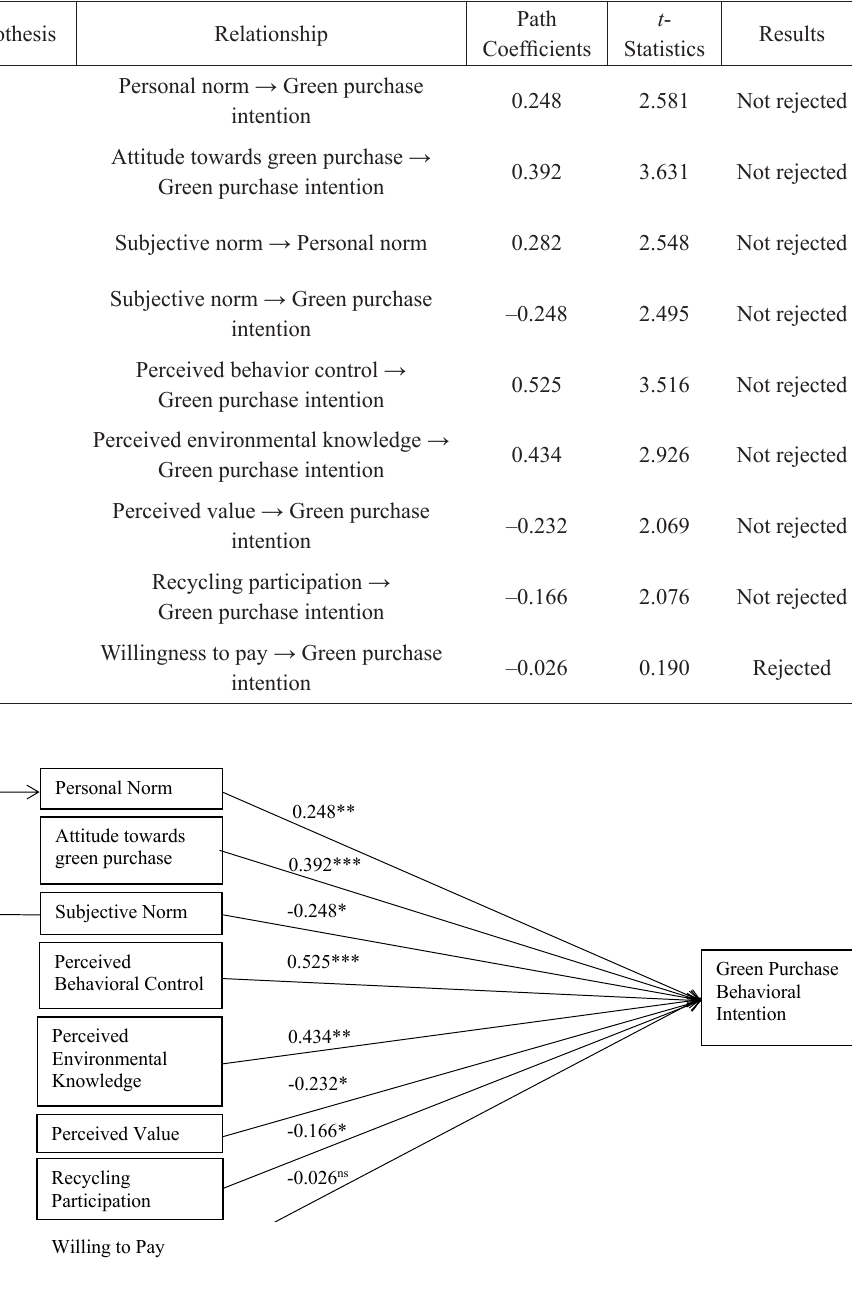
Figure 2. Path analysis result.